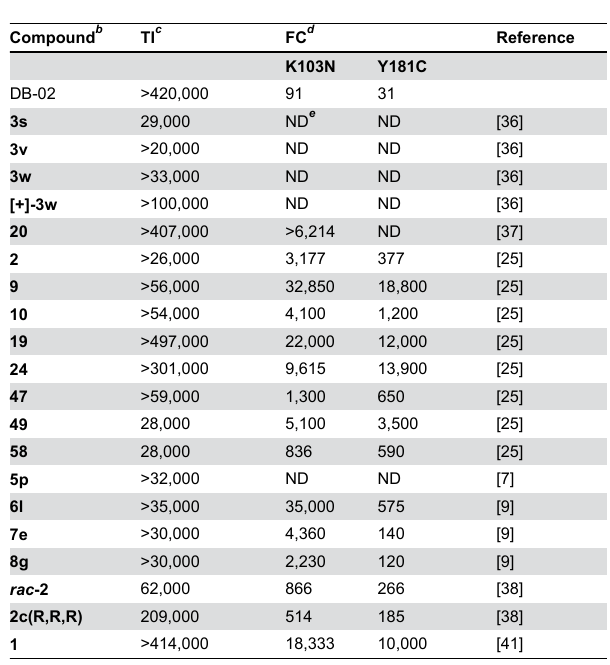
Table 6. Recent S -DABOs with high inhibitory activity in comparison of DB-02 a